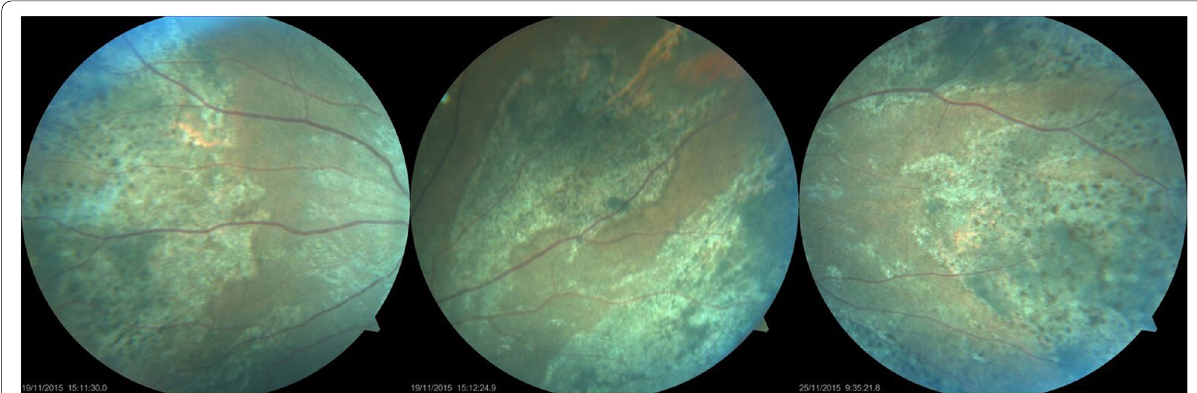
Fig. 3 Color fundus photographs of a patient with hypertensive disease and renal insufficiency showing peripheral wedge‑shaped triangular areas of pigmentary changes in both eyes indicating sequelae of the Amalric sign of choroidal infarction. (Courtesy of Prof. Gürsel Yilmaz,